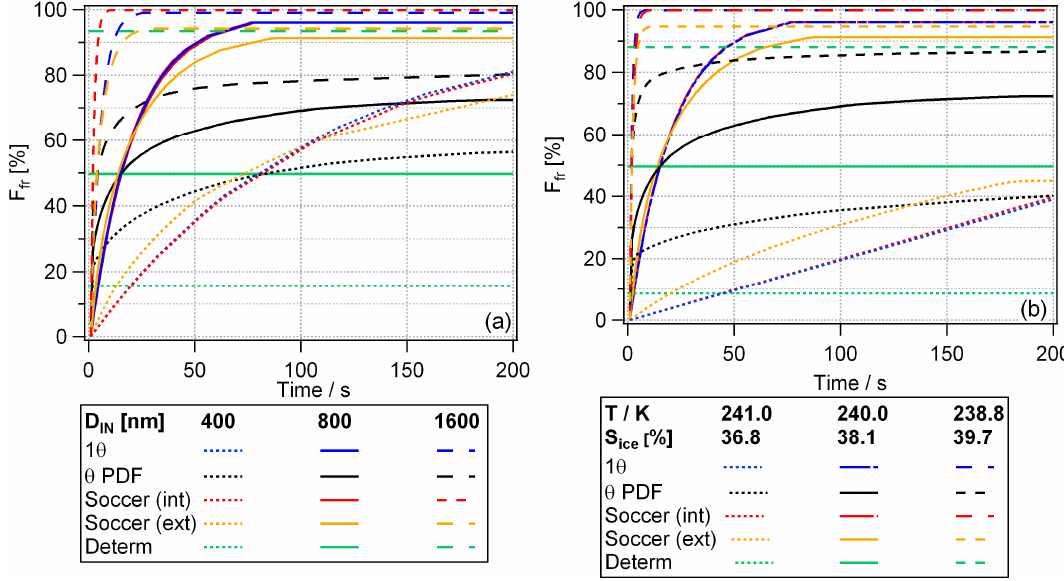
Fig. 3. Box model results for constant temperature and supersaturation. (a) Variation of the ice nuclei diameter D IN ( T = 240K, S ice = 38 . 1%; S w = 0 . 2%); (b) Variation of temperature and S ice ( D IN = 800nm, S w = 0 . 2%)